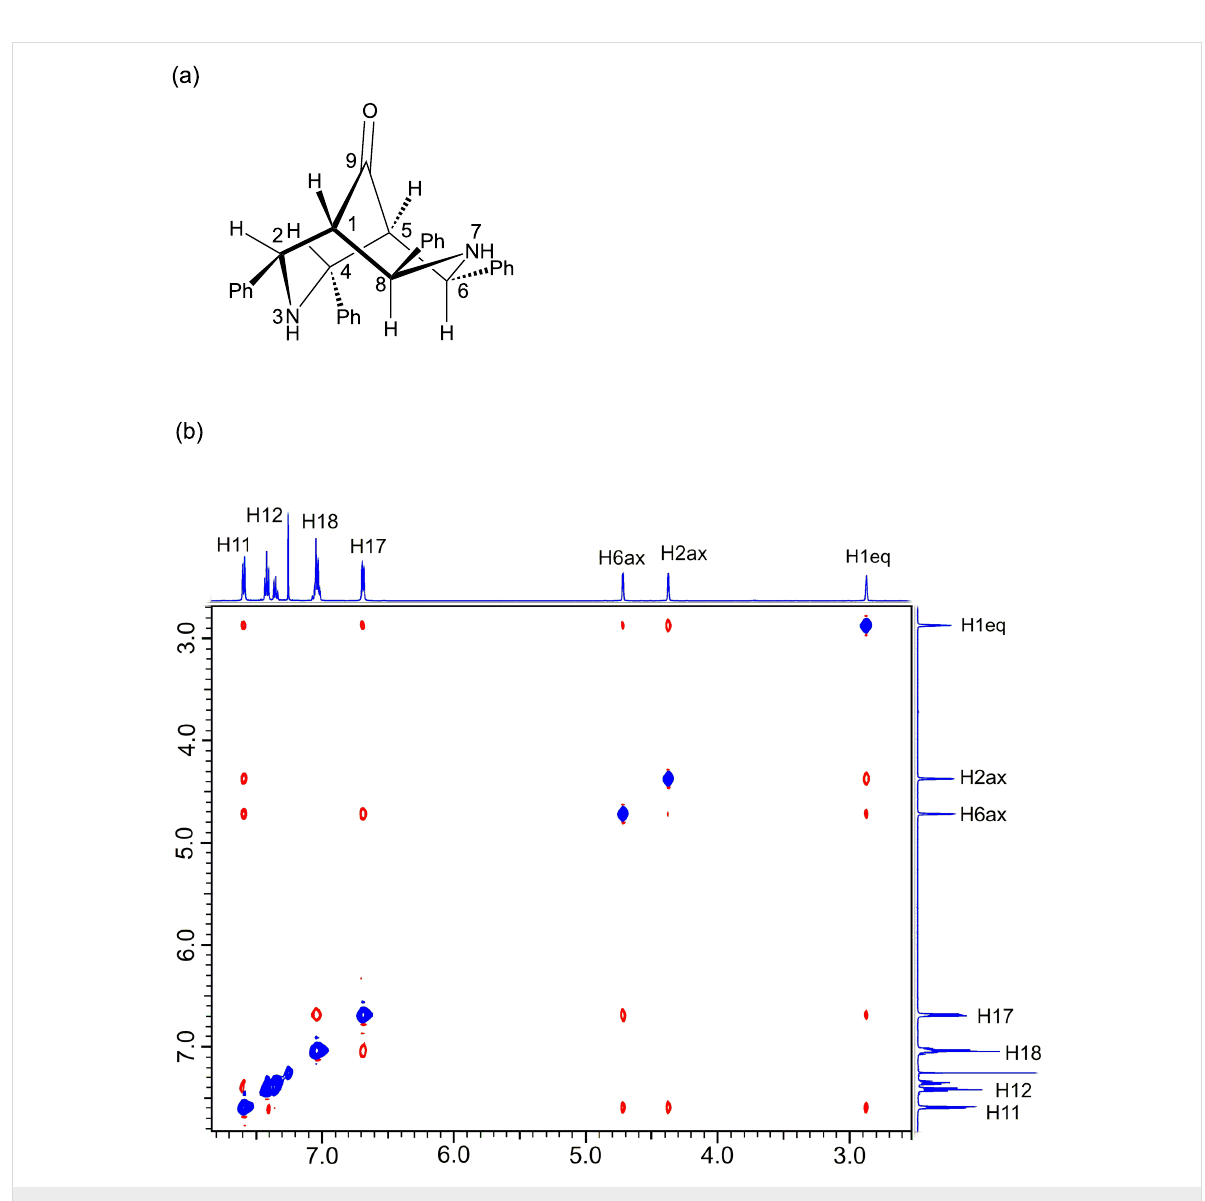
Figure 5: (a) Favored conformation for compound 1 , determined by nOe effect, (b) t-ROESY spectrum of 1 recorded at 500 MHz in CDCl 3 .